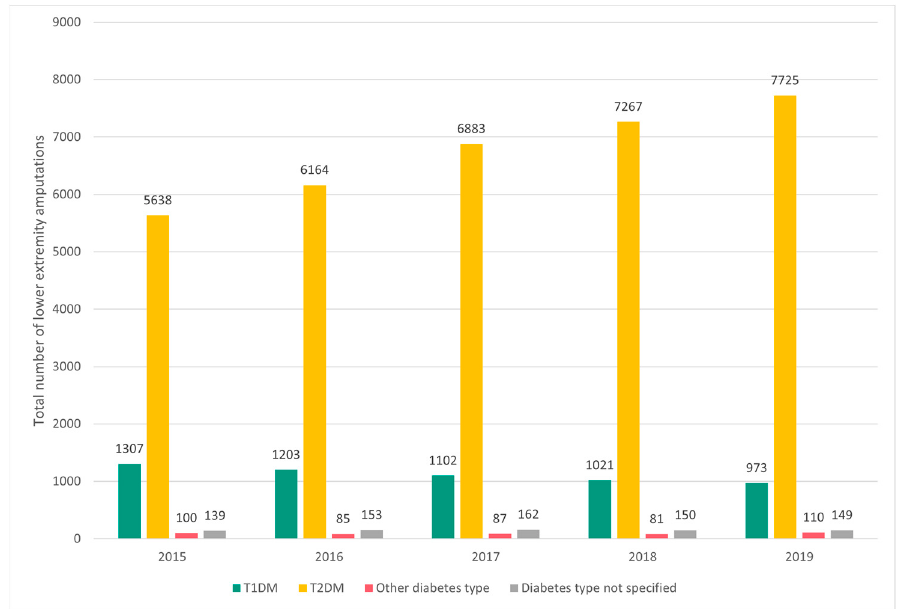
Figure 1. Total number of nontraumatic lower extremity amputations per year, according to diabetes type. T1DM, type 1 diabetes mellitus; T2DM, type 2 diabetes mellitus.